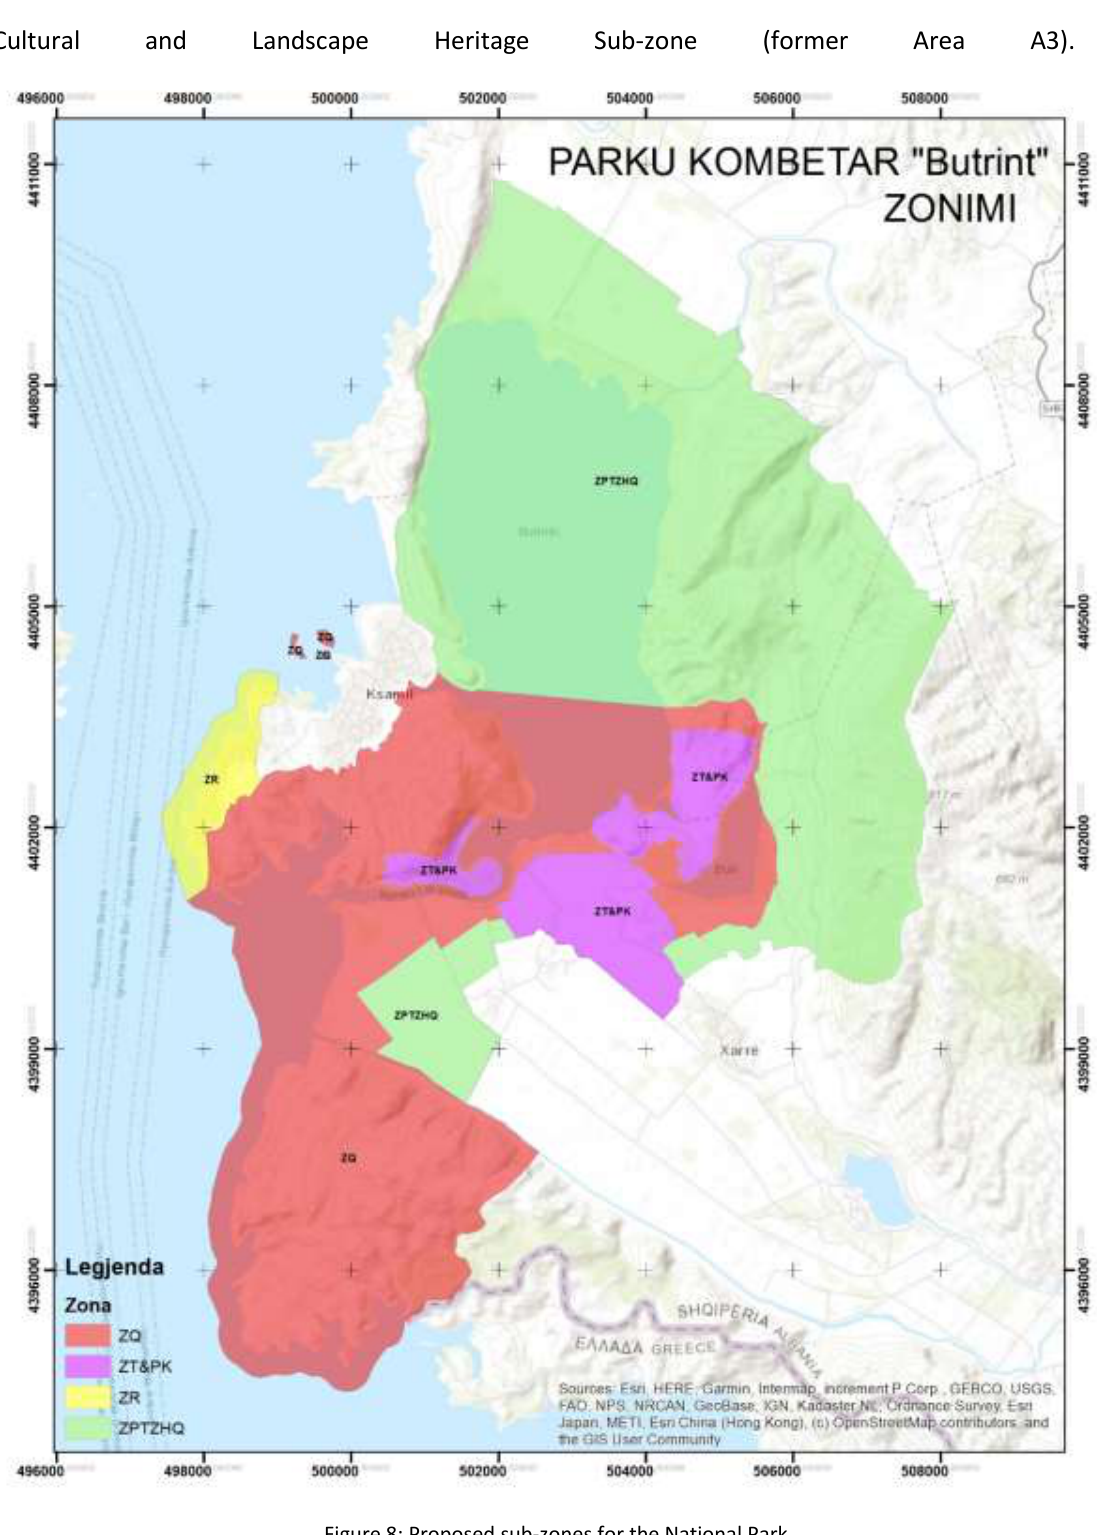
Figure 8: Proposed sub-zones for the National